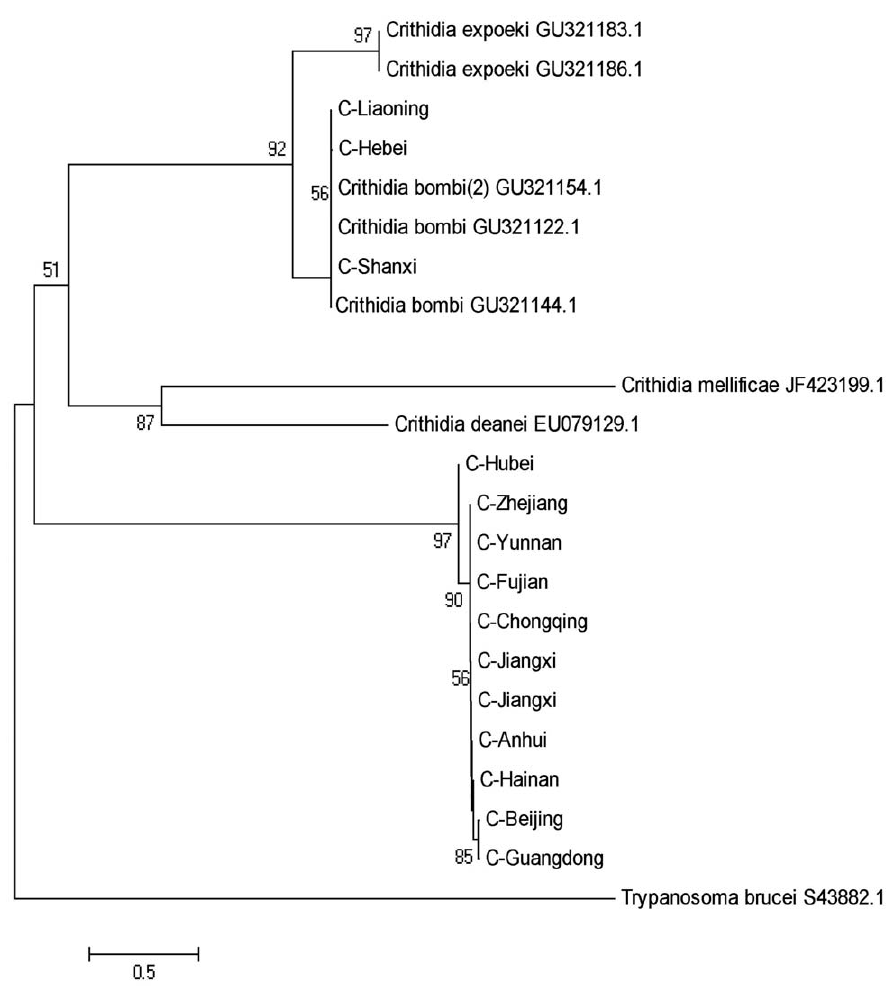
Figure 3. A phylogenetic tree showing the relationship of C.bombi isolates. The partial sequences of 18 S ribosomal RNA of C. bombi from Apis cerana collected from different geographic locations of China and from bumble bee species retrieved from GenBank were aligned using ClustalW. The tree was built using the Neighbor-Joining method. The sequence of Trypanosoma brucei was used as an outgroup to root the tree. Numbers at each node represent bootstrap values as percentages of 500 and only bootstrap values greater than 50% are